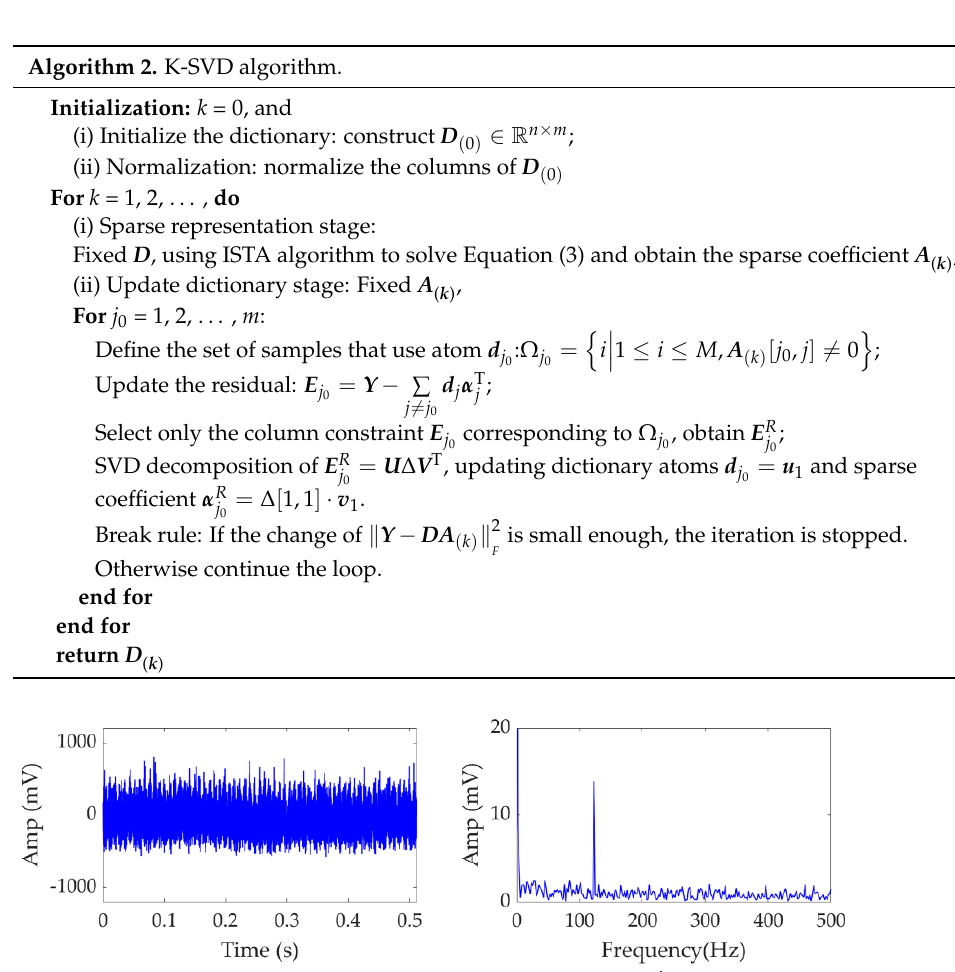
Algorithm 2. K-SVD algorithm.